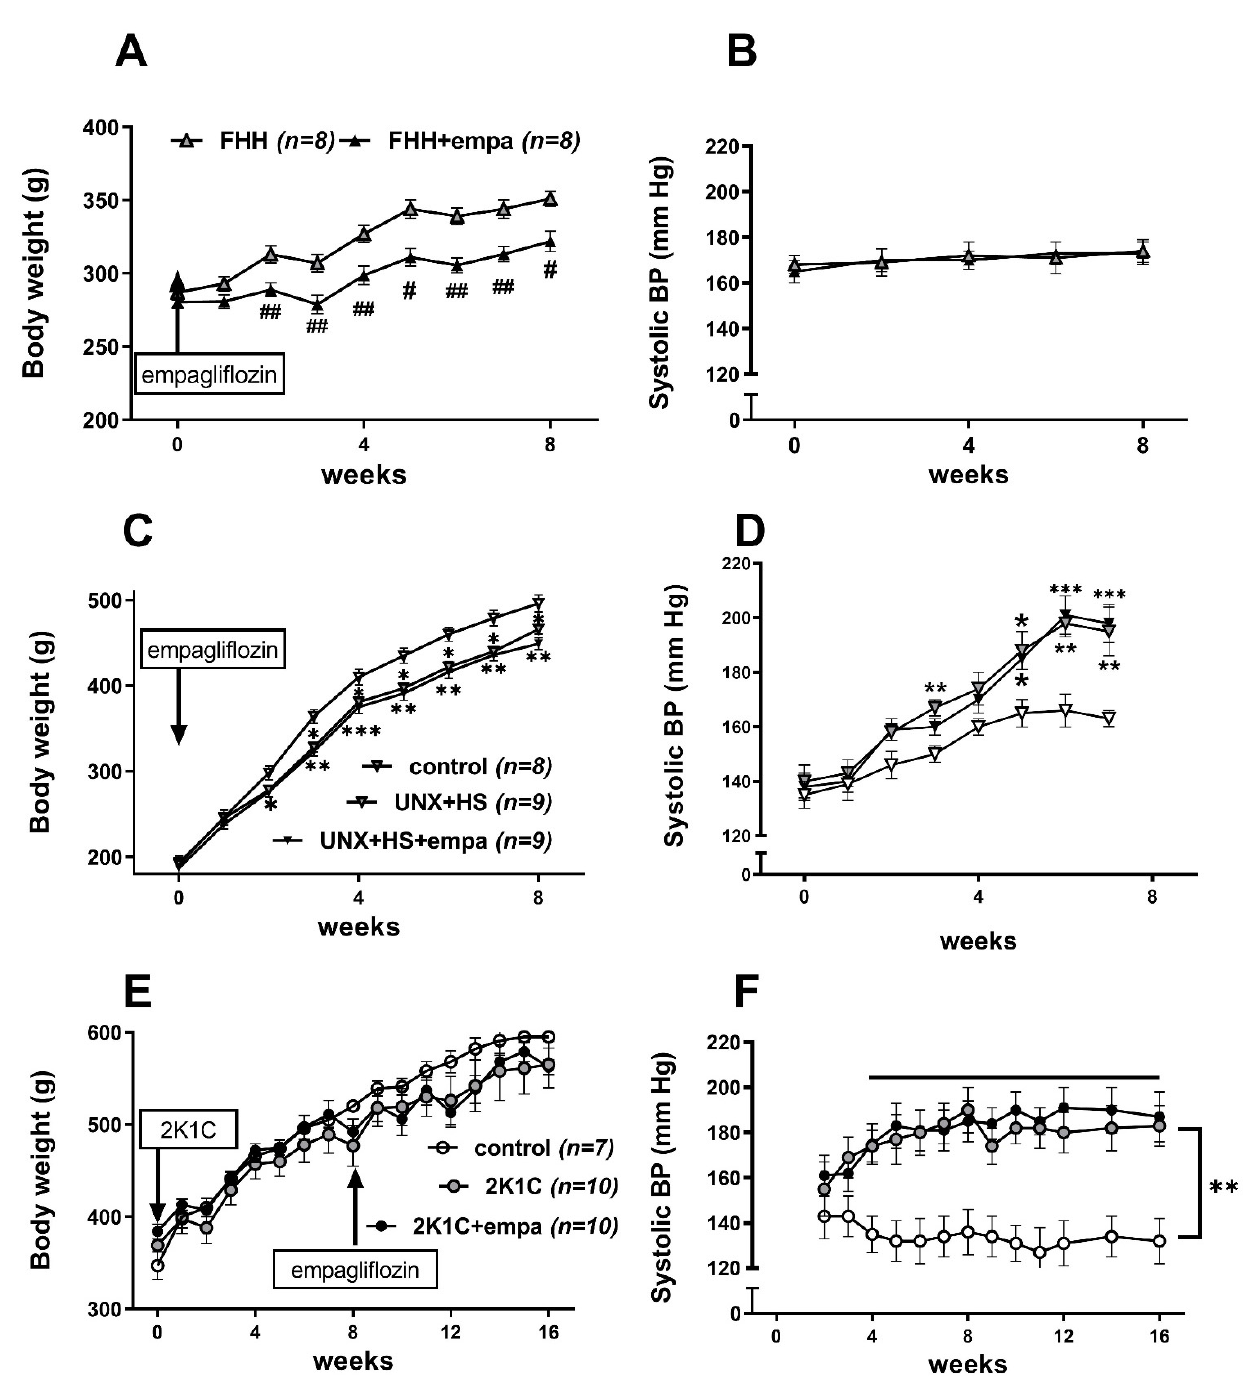
Figure 2. The effect of empagliflozin treatment on body weight ( A , C , E ) and systolic blood pressure ( B , D , F ) in fawn-hooded hypertensive (FHH) rats ( A , B ), uninephrectomized (UNX) Hannover Sprague Dawley (HanSD) rats on a high-salt (HS) diet ( C , D ), and Wistar rats subjected to renal artery stenosis (Goldblatt 2K1C hypertension) ( E , F ). * p < 0.05 vs. control group, # p < 0.05 vs. untreated group. * denotes p < 0.05; ** and ## denotes p < 0.01; *** denotes p < 0.001; data are means ± SEM. Horizontal line in ( F ) depicts time points with significantly different BP levels.